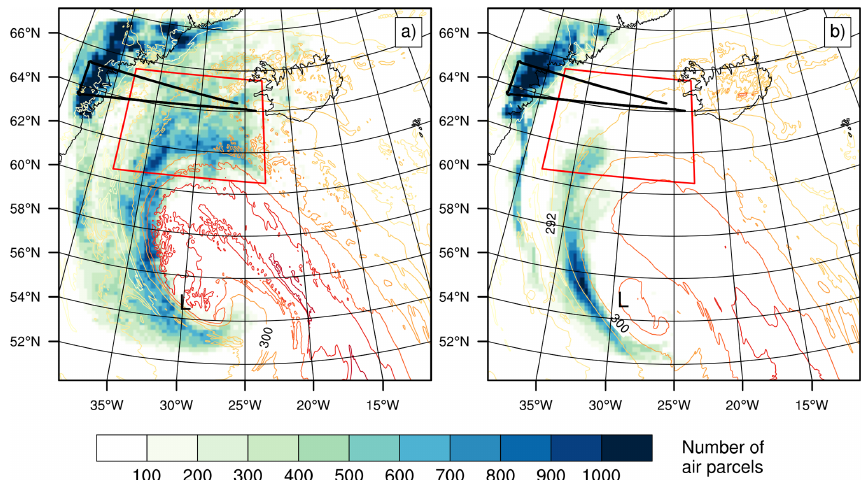
Figure 5. Number of air parcels belonging to the ascents fulfilling the ascent criterion (shading) and θ e at 1km altitude (colored lines every 4K between 288 and 312K) at 11:00UTC, simulated by (a) REF and (b) NODIA. The black line shows the track of the Falcon 20 aircraft, L the low-pressure center and the red box shows the region where the ascents are selected at